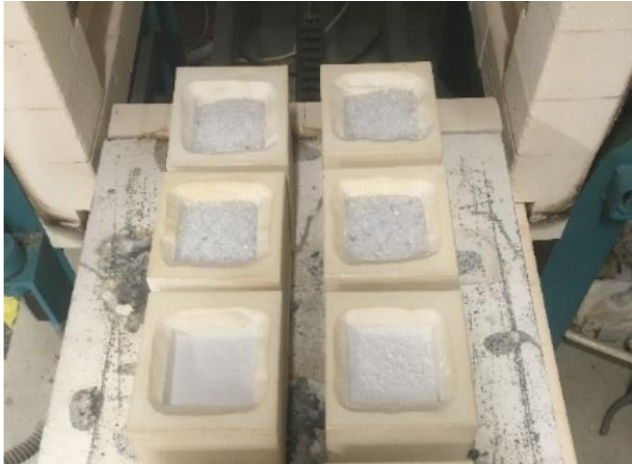
Fig. 5 Molds inside the oven ready for the